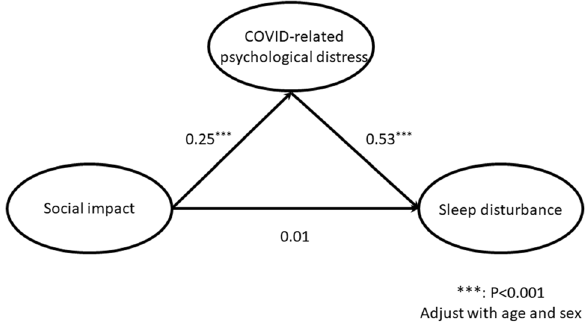
Figure 1. Final model of the mediating effect indicating the estimated coefficients of the